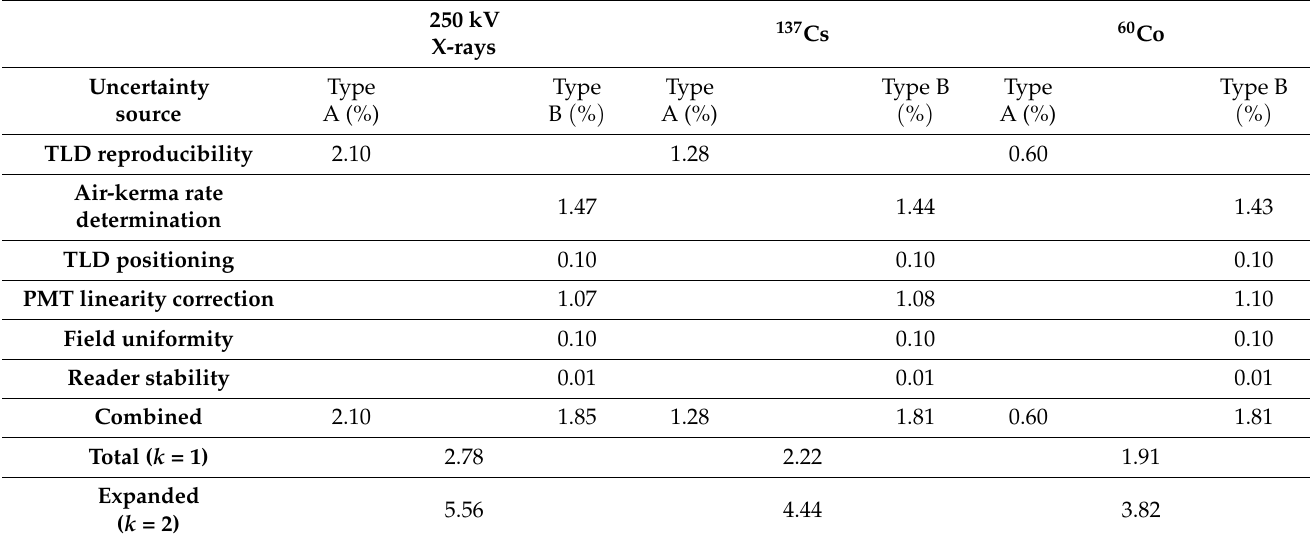
Table 5. Measured CFs for different average radiation energies with estimated expanded uncertain- ties Δ CF.